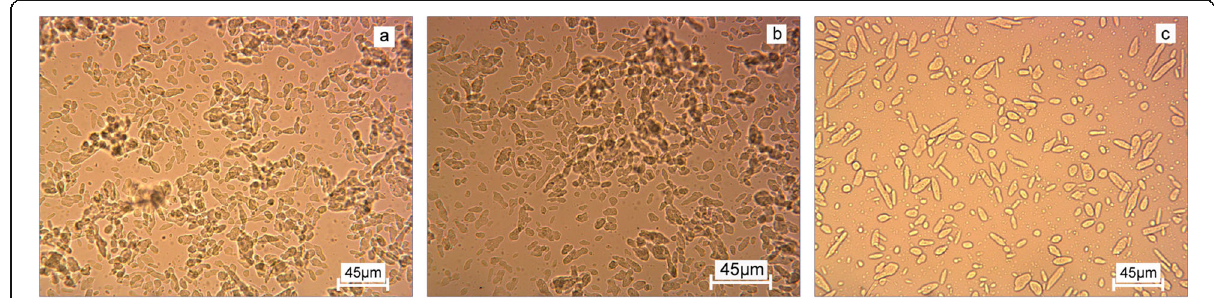
Fig. 5 The microcapsule morphology at different pH values with the gelatin/CMC ratio of 11: 1. a pH= 4.69, b pH= 4.74, c pH= 4.78. When the ratio of gelatin/CMC was 11:1, the pH range of microcapsules for pellet formation was between 4.69 and 4.74